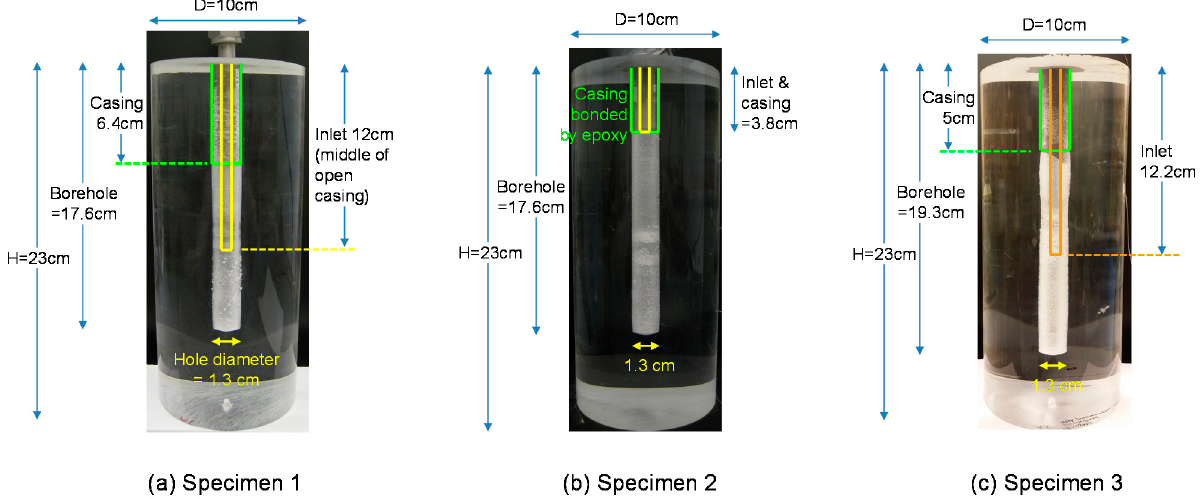
Figure 2. Dimensions of the PMMA specimens and the locations of the stainless steel casings and inlet tubes.